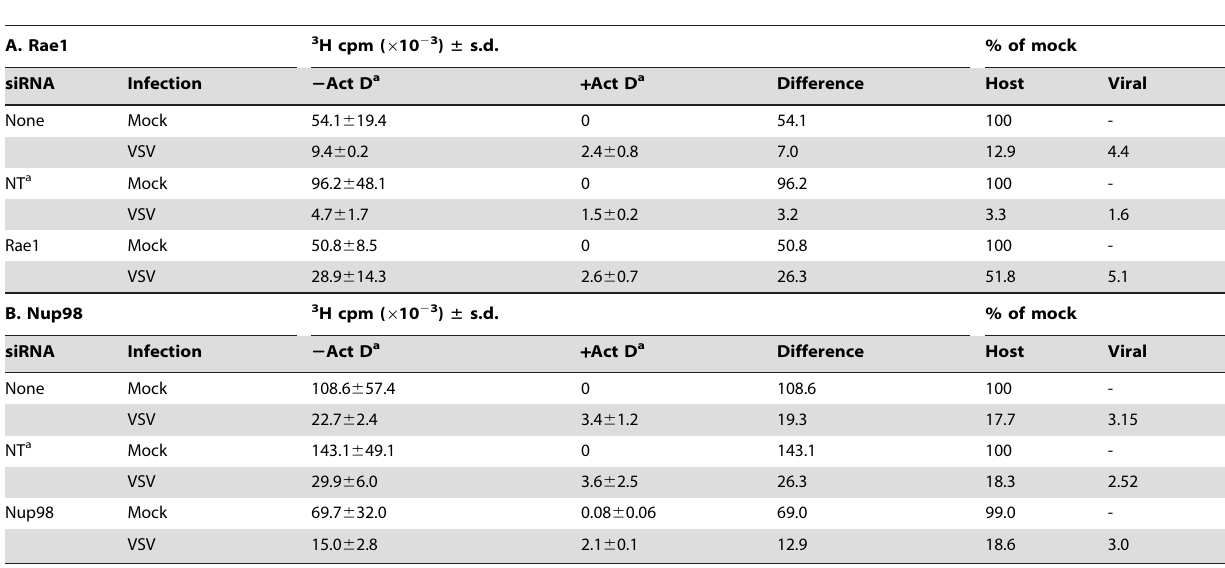
HeLa cells transfected with the indicated siRNA were either mock-infected or infected with VSV in the presence or absence of actinomycin D. At 6 h postinfection, cells were labeled with 3 H uridine for 30 min; RNA was acid-precipitated, and radioactivity was determined by scintillation counting. Data shown are mean 6 s.d. for triplicate cultures from a representative experiment. a Abbreviations: ActD - actinomycin D; NT – non-targeting